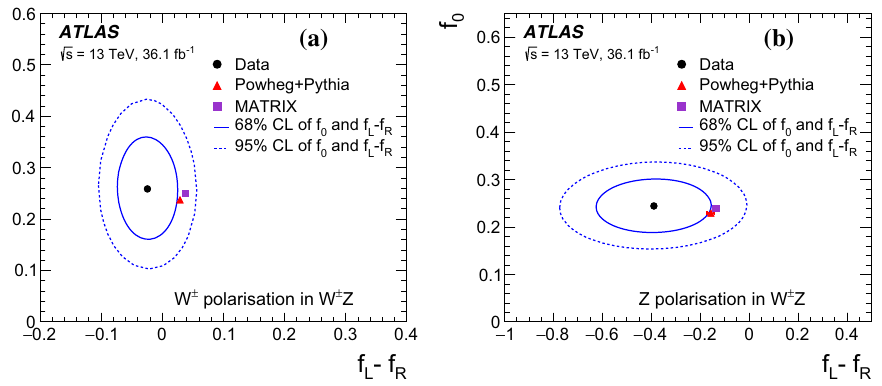
Fig. 10 Measured helicity fractions f 0 and f L − f R for a the W and b Z bosons in W ± Z events, compared with predictions at LO for the electroweak interaction and with sin 2 θ W = 0 . 23152 from Powheg+Pythia (red triangle) and MATRIX (purple square). The effect of PDF and QCD scale uncertainties on the Powheg+Pythia